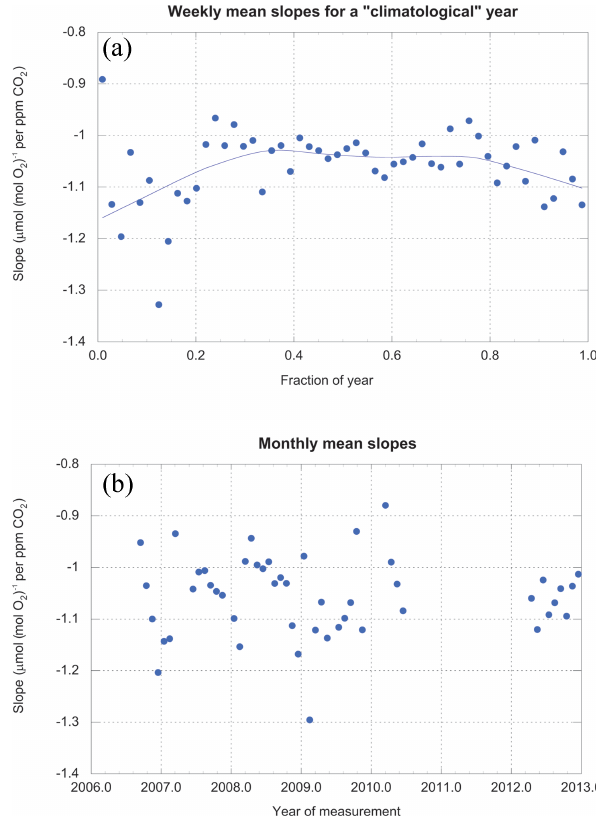
Figure 10. (a) Slopes (averaged weekly) for a climatological year. (b) Slopes (averaged monthly) for the entire period of study. The gray line in (a) is a locally weighted least-squares fit with 46% smoothing. It is simply intended as an objective guide to the